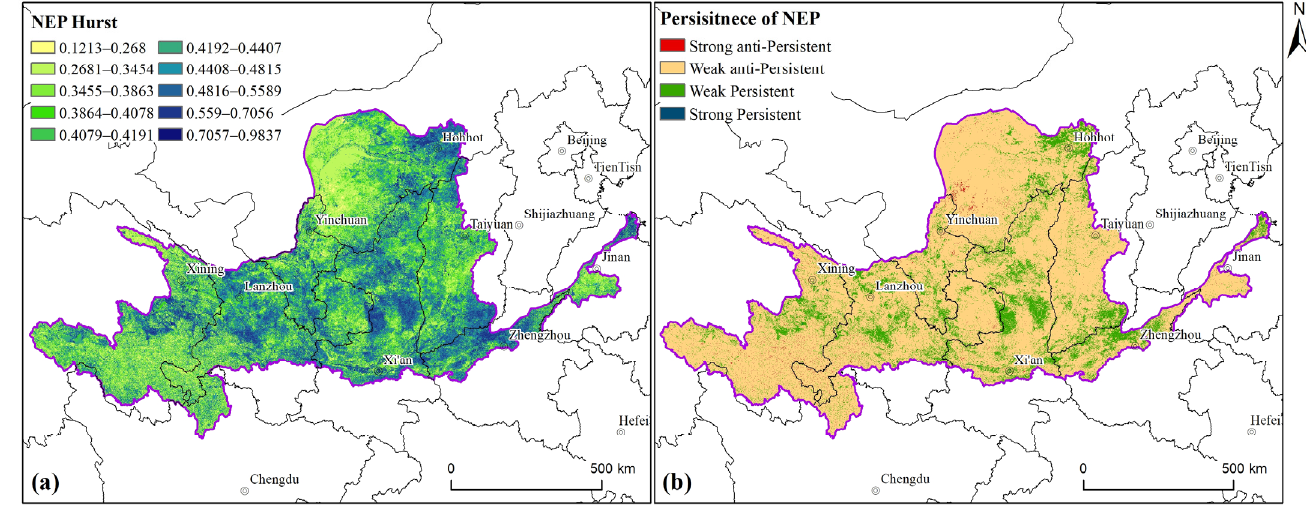
Figure 10. NEP Hurst index and persistence characteristics distribution. ( a ) Calculation results of the Hurst index of NEP, displayed in 10 levels. ( b ) Hurst index results through the significance test and the hierarchical display. We call it ‘Persistence of NEP’.